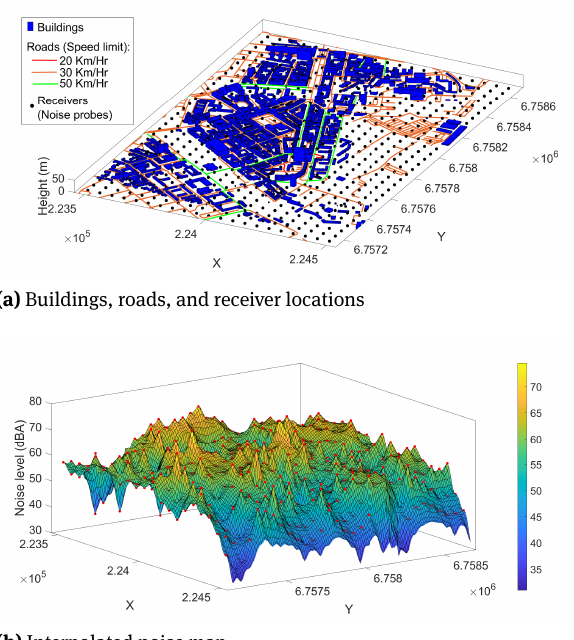
are color-coded per the speed limit. Dynamic noise mea- surements are simulated for ten days (three noise maps per day for day, evening, and night) by placing a uniform a × b rectangular grid of noise probes (receivers) separated by 50m, as shown by black dots. A dataset of 30 noise maps corresponding to consecutive time instances is